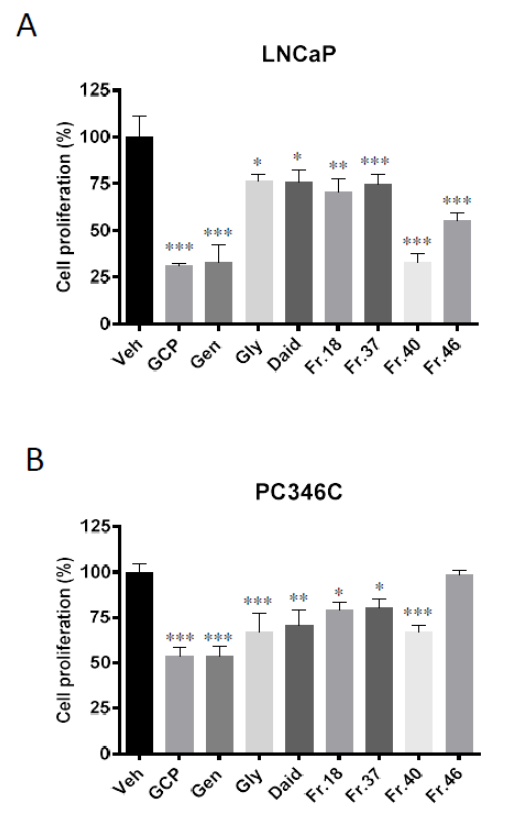
Figure 3. Fractionation of GCP followed by bioassay identifies fraction 40 as having the highest level of anti-proliferative activity in prostate cancer cell lines. Out of the 50 GCP fractions tested, only three fractions (fraction 18 (Fr.18), 37 (Fr.37), and 40 (Fr.40)) mediated a statistically significant decrease in the proliferation of both ( A ) LNCaP cells (~1.3-fold, ~1.3-fold, ~3.3-fold decrease, respectively) and ( B ) PC346C cells (~1.2-fold, ~1.2-fold, ~1.5-fold decrease, respectively) compared to the vehicle control (Veh). Fraction 46 (Fr.46) showed anti-proliferative activity in LNCaP cells (~2-fold decrease in proliferation) but not in PC346C cells. Genistein (Gen), daidzein (Daid), and glycitein (Gly), all of which are key components of GCP, also inhibited cell proliferation of both LNCaP (~3.3-fold, ~1.3-fold, ~1.3-fold, respectively) and PC346C cells (~1.9-fold, ~1.5-fold, ~1.5-fold, respectively). (GCP (100 µ g / mL), genistein (9 µ g / mL), daidzein (6 µ g / mL), glycitein (2 µ g / mL), GCP fractions (concentrations used were reflective of their concentration in 100 µ g / mL GCP, as determined by LC-MS analysis)). (* = p < 0.01, ** = p < 0.001, *** = p <